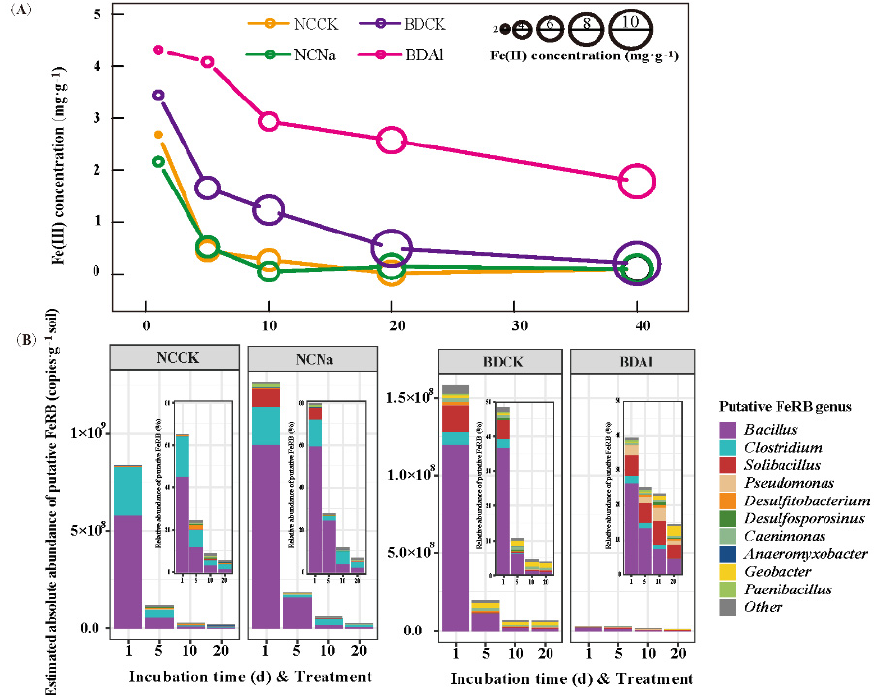
Figure 3. Variation in content of Fe(III) and Fe(II) ( A ) and the estimated abundance of putative Fe(III) reducing bacteria ( B ) during flooding of paddy soils with acidification or alkalization. The area of circles was the content of Fe(II) in soils.